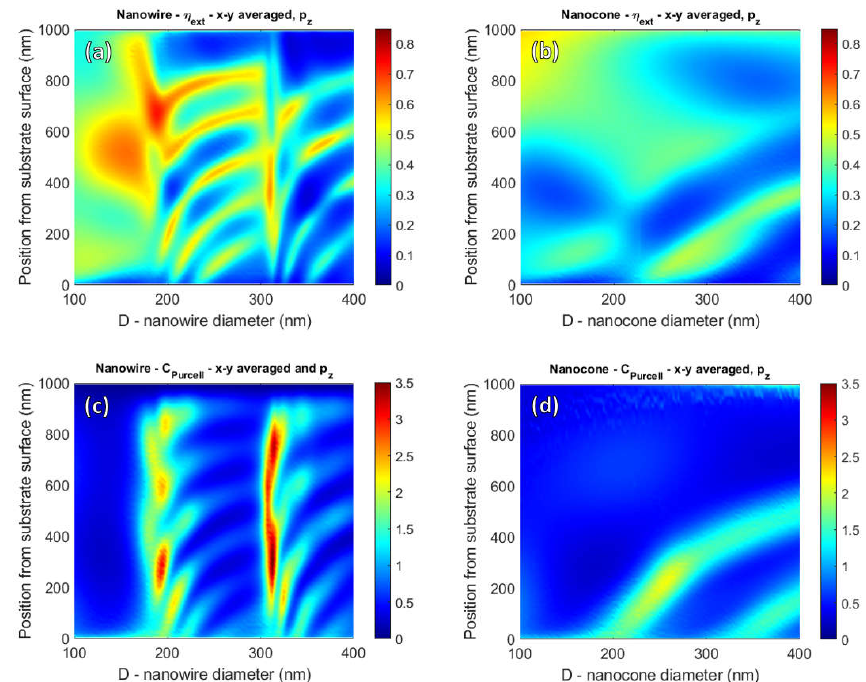
Figure 6. ( a , b ) Extraction efficiency, η ext , and ( c , d ) Purcell factor, C Purcell , for ( a,c ) a nanowire and ( b,d ) a nanocone. Here, we consider an emitter region that is 10 nm thick in the axial z -direction, and